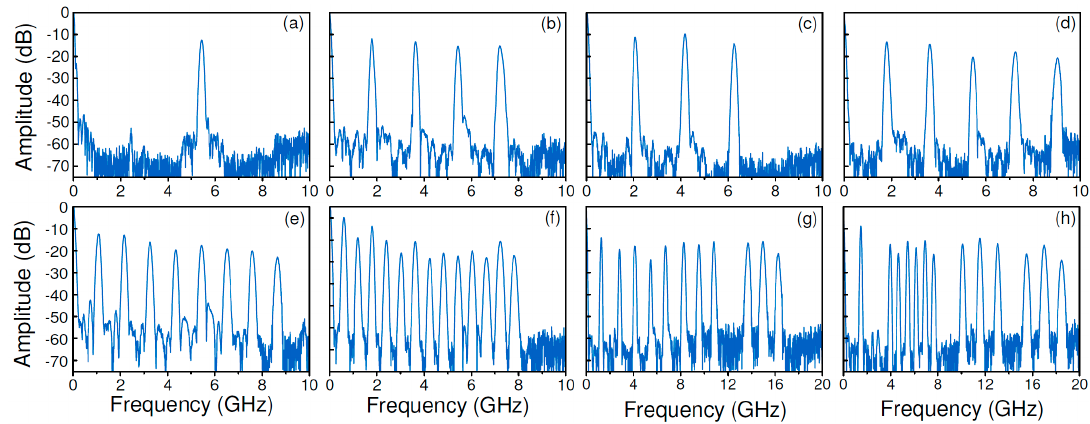
Figure 11. Measured frequency spectra of the tunable and reconfigurable microwave photonic multiband filter with different passband combinations [36]. ( a ) One single passband. ( b – d ) Three to five passbands. ( e ) Eight passbands. ( f ) Thirteen passbands with evenly distributed frequency spacing. ( g ) Eleven passbands. ( h ) Thirteen passbands with uneven frequency spacings.